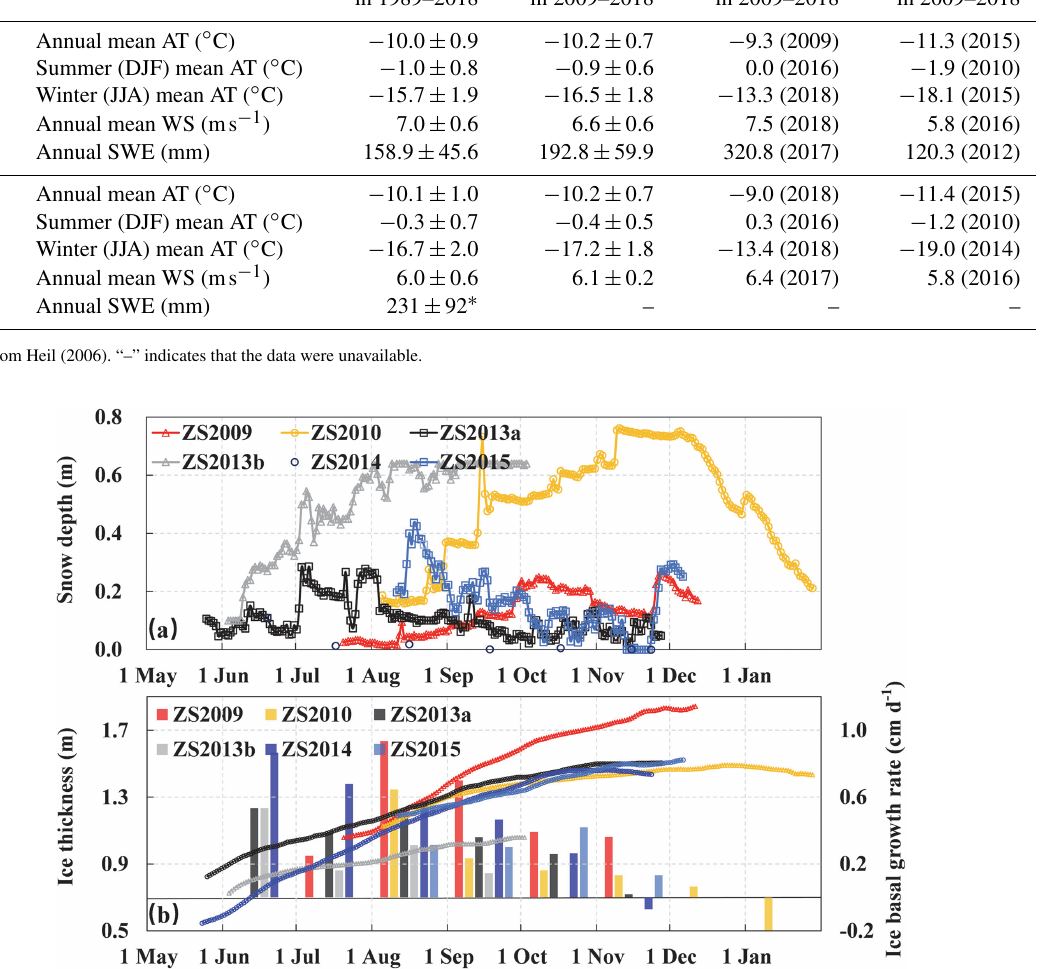
Table 2. Statistics of the principal meteorological parameters at ZS and DS. Station